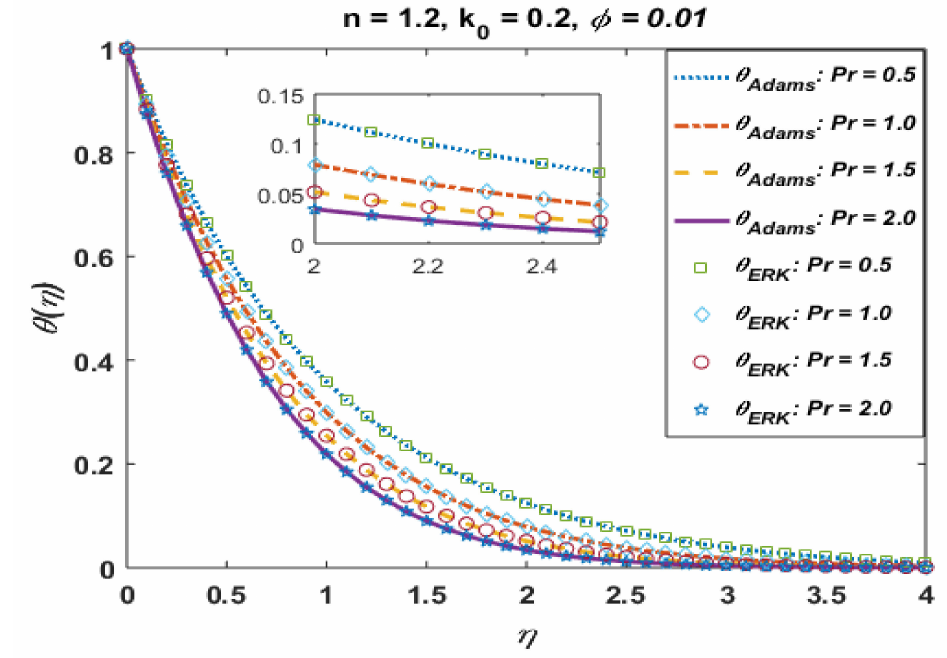
Figure 13. Effects of Pr on θ ( η ) .